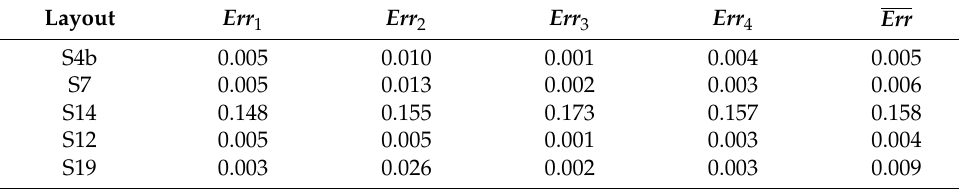
Table 4. Normalized errors on control sensors for each reconstruction layout.